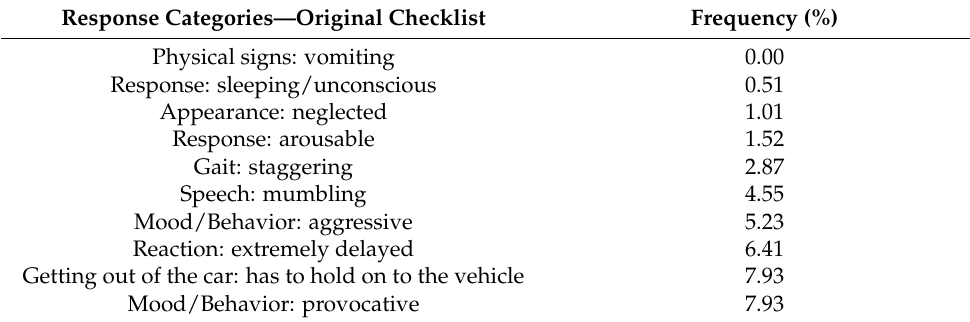
Table 2. Frequencies of rarely reported response